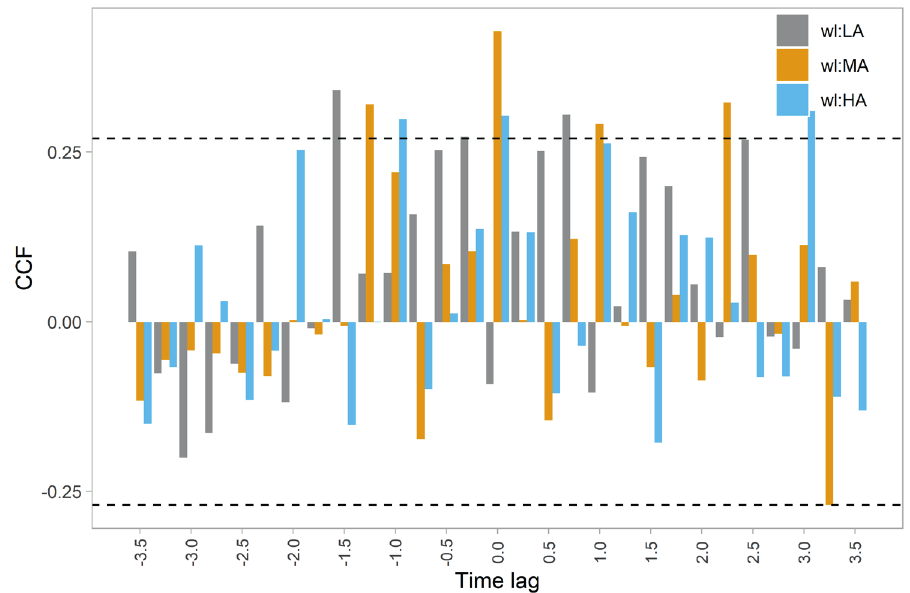
FIGURE 3 | Cross-correlations between the temporal abundance series of the less altered (LA) and moderately altered (MA) rivers (LA:MA) and the LA and HA rivers (LA:HA). As sampling was conducted quarterly. A 0.25 lag is equal to three months. HA: Paraná River; MA: Baía River; LA: Ivinhema River). CCF = cross-correlation coefficient. After the prewhitening protocol correlations, < -0.27 and > 0.27 were considered significant (dashed